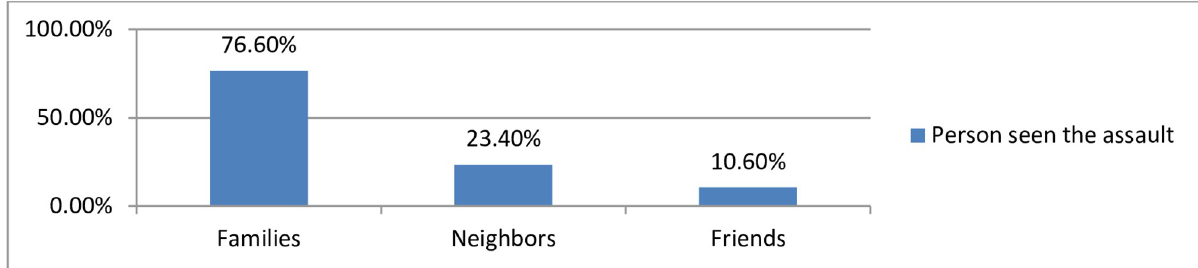
Fig 1. Individuals who have seen when the victims were assaulted during armed conflicts in Northeast Ethiopia, 2022 (n =